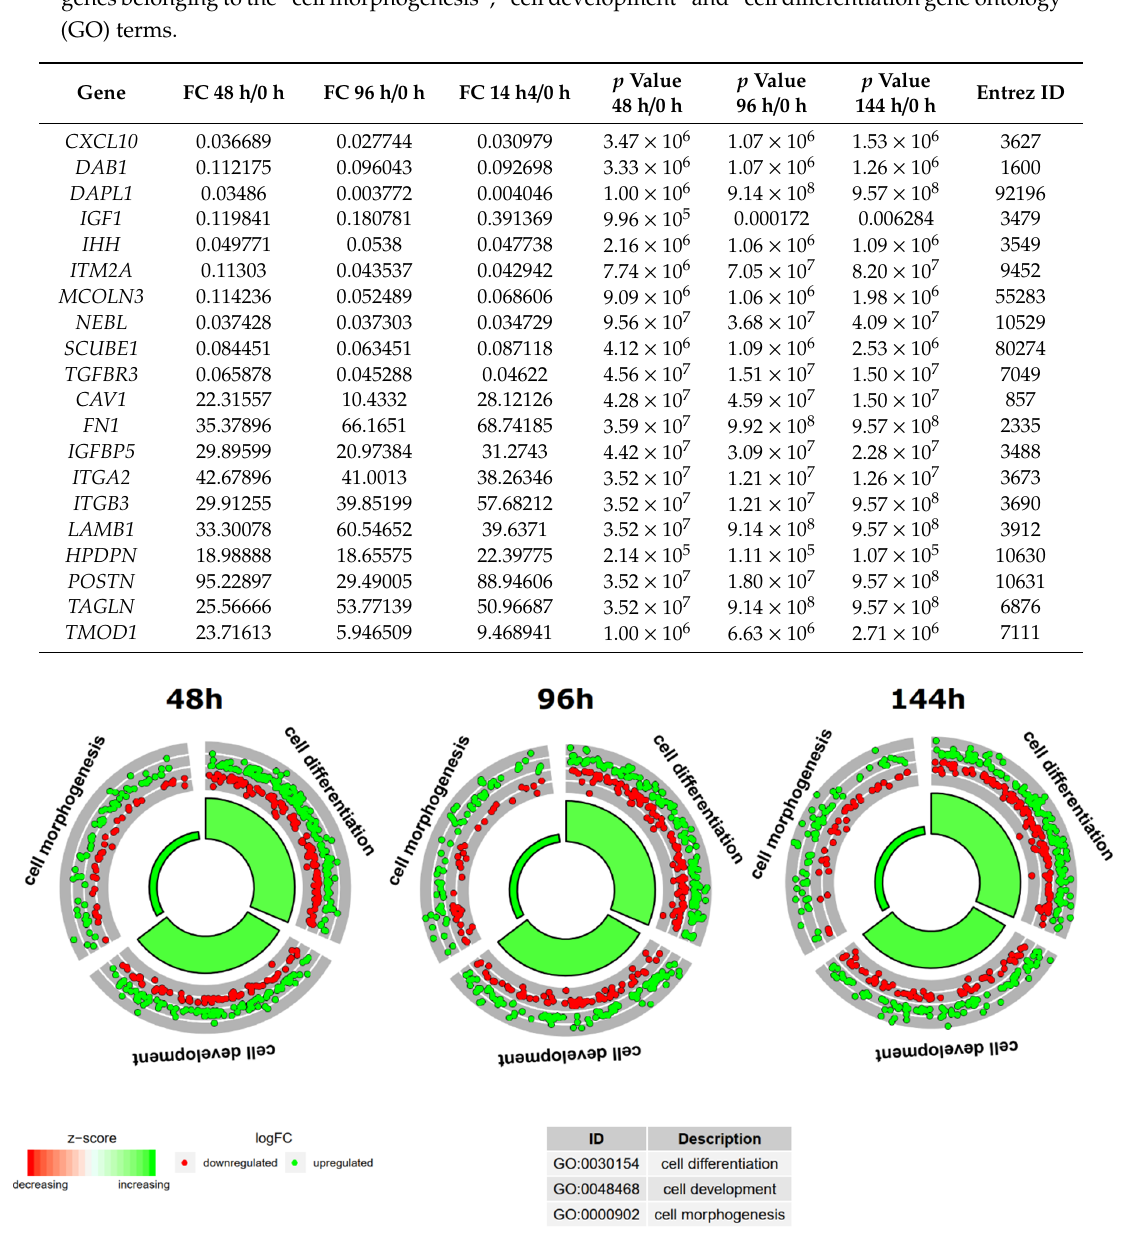
Figure 2. The circular visualization of the results of gene-annotation enrichment analysis. The outer circle shows a scatter plot for each term of the logFC of the assigned genes. Red circles display up-regulation and blue ones down-regulation. The inner circle is the representation of the z-score. The size and the color of the bar correspond to the value of z-score.